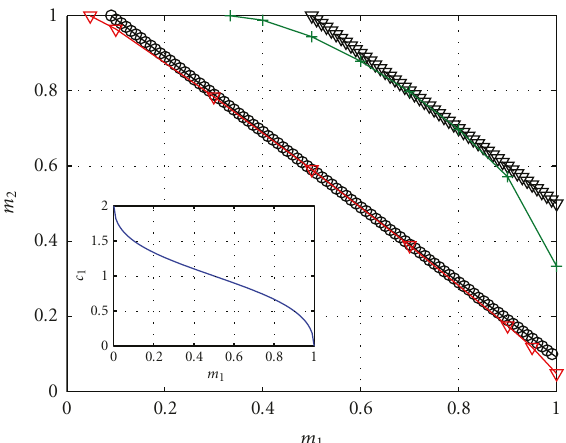
Figure 8: Guaranteed MSE region for symmetric and optimal user placement for SNR 0dB and 10dB in CDWO